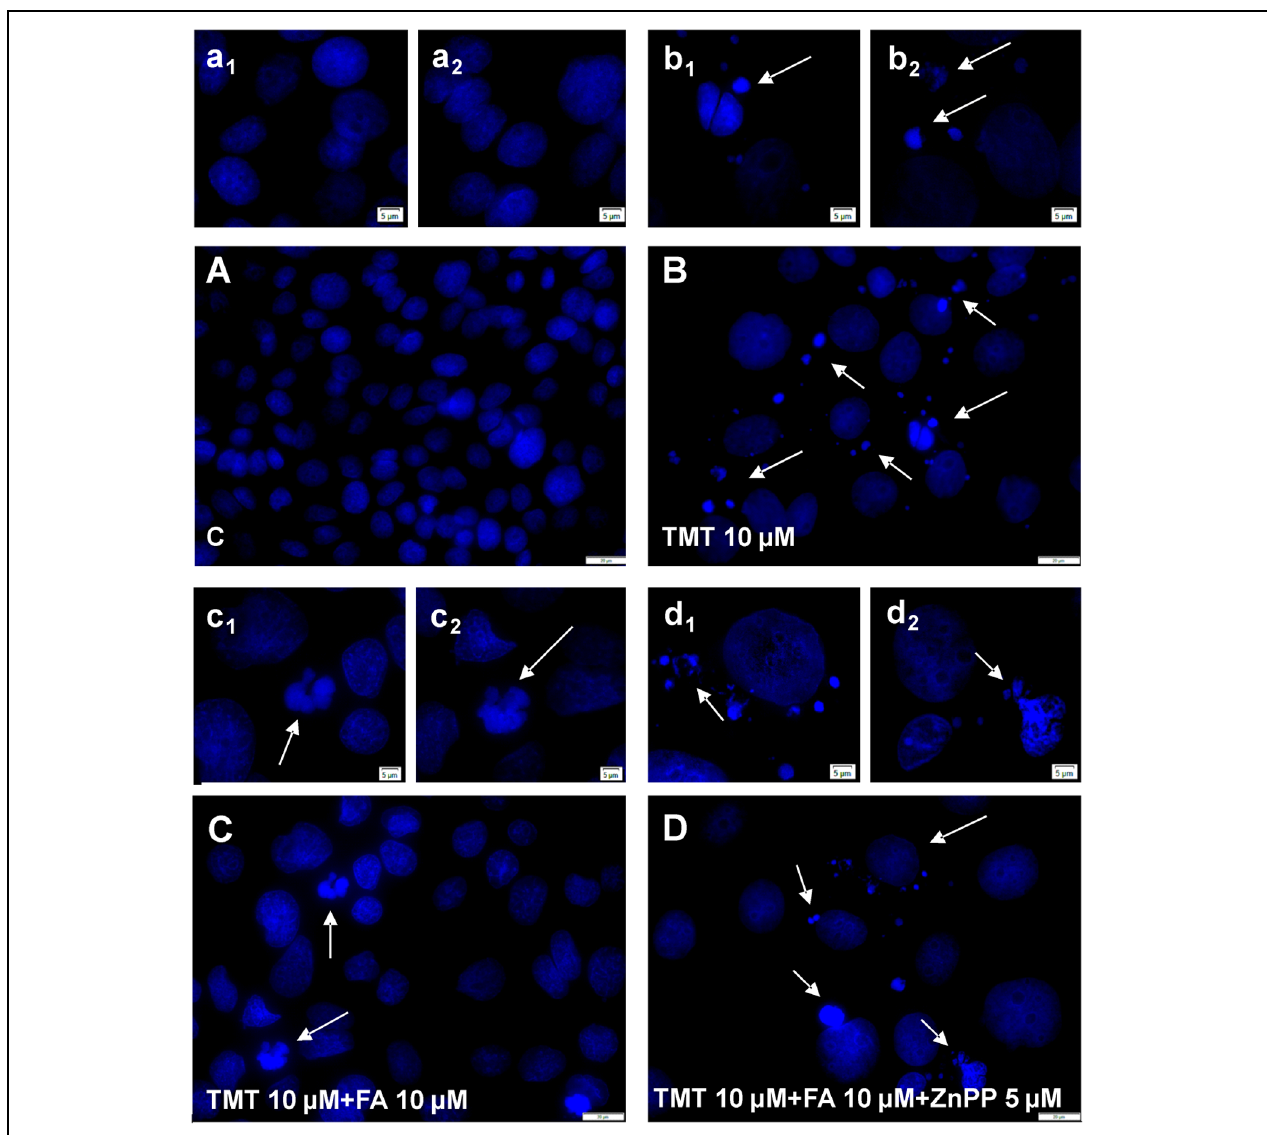
FIGURE 6 | Ferulic acid neutralizes TMT-induced DNA fragmentation through the modulation of HO activity. Representative immunofluorescence images of SH-SY5Y cells stained with DAPI at low magnification (20 × , A–D) and high magnification (40 × , a 1 –d 2 ). Control cells (A) showed no morphological signs of DNA fragmentation. TMT (10 μ M, B) induced morphological signs of cytotoxicity such as nuclei condensation and nuclear fragmentation (see arrows). This effect was counteracted by FA (10 μ M, C) pre-treatment. When HO activity was inhibited by ZnPP (5 μ M) in TMT (10 μ M) + FA (10 μ M) treated cells (D) , nuclear fragmentation and condensed nuclei were detected, with no difference compared to TMT treatment (see arrows). Scale bar: (A–D) 20 μ m; a 1 –d 2 : 5 μ m. For further information see